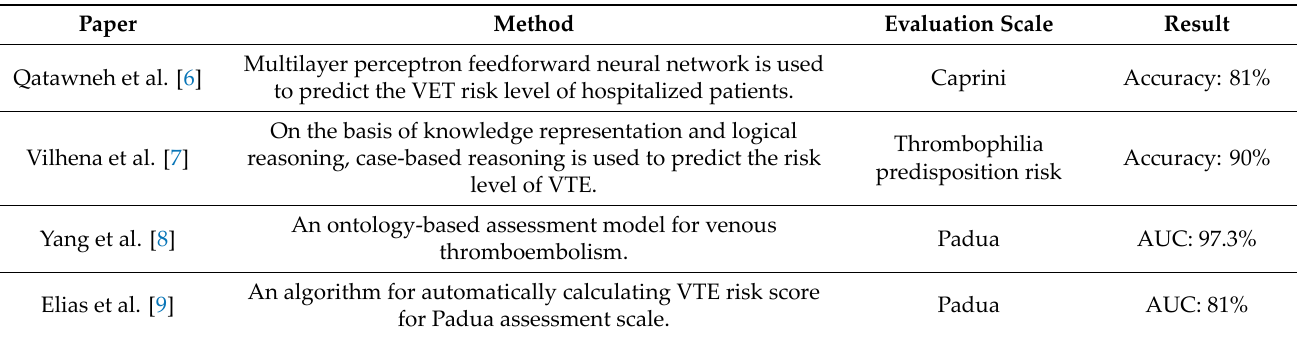
Table 1. The recent